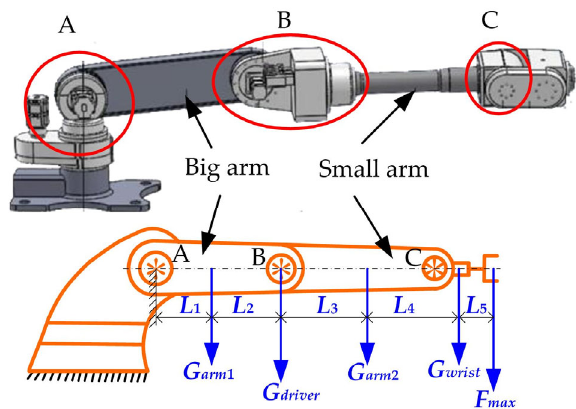
Figure 7. Force analysis.